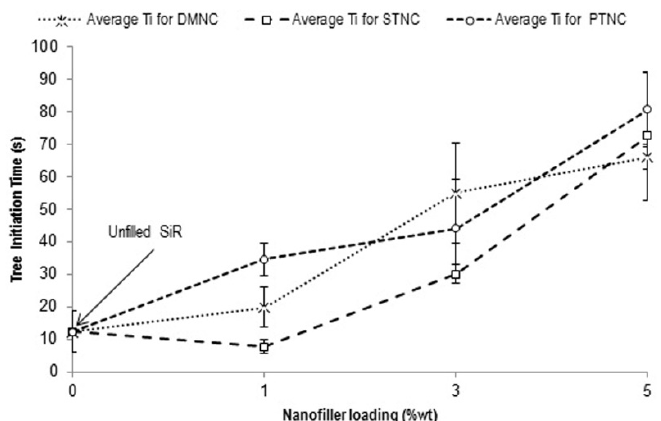
Figure 6. Tree initiation time for directly mixed nanocomposites (DMNC), silane-treated nanocomposites (STNC), and plasma-treated nanocomposites (PTNC).